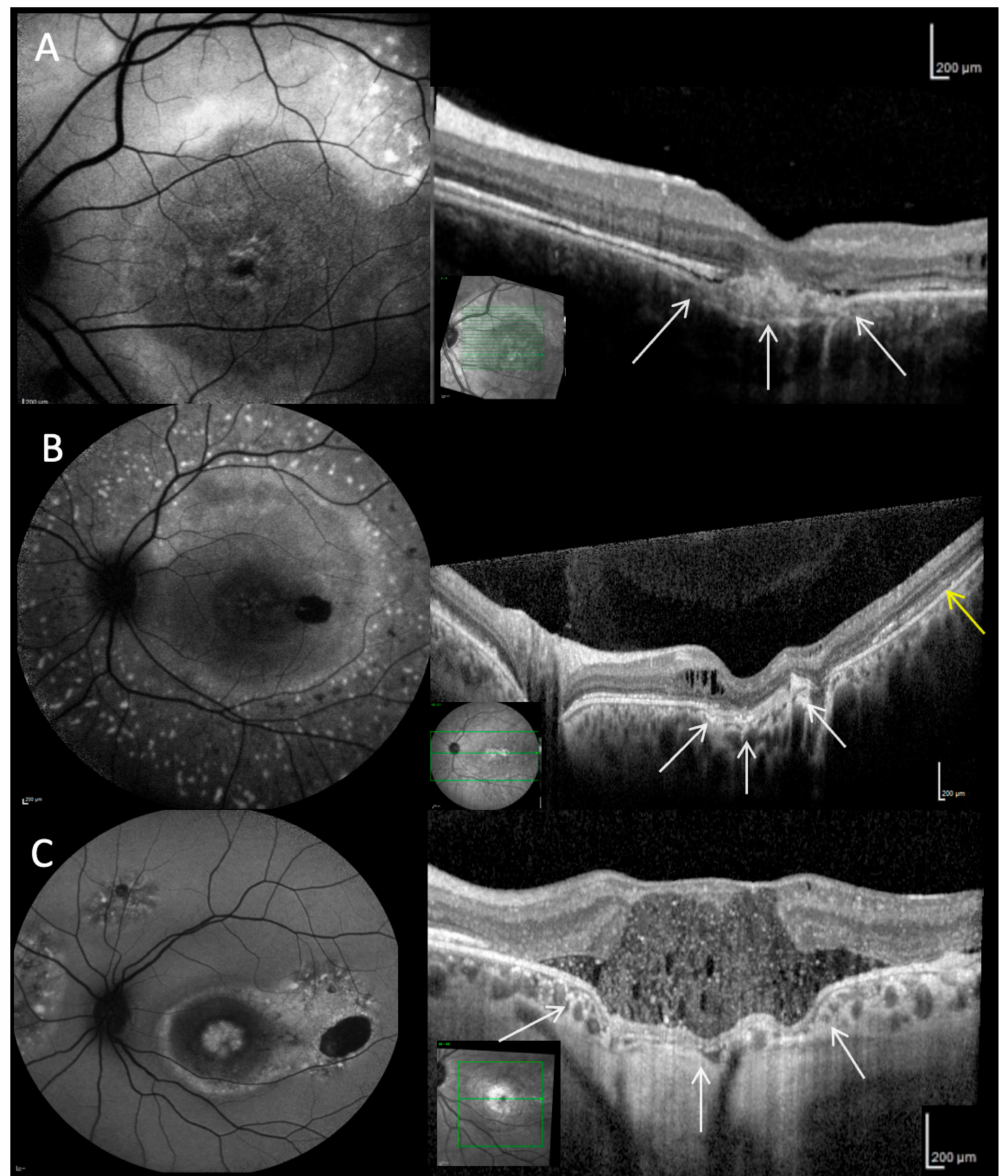
Figure 4. Focal and large choroidal excavation. ( A ) FAF 30 ◦ image shows confluent subretinal deposits with increased intensity arranged concentrically around the fovea (#2). OCT shows focal choroidal excavation (white arrows), a large lesion below the RPE / Bruch’s membrane complex subfoveally. Temporally, few intraretinal cystoid lesions are visible. ( B ) FAF 55 ◦ image shows multiple apparent spots with increased intensity surrounding the vessel arcades in a starry sky-like appearance (#8). The wide-field OCT shows foveal atrophy of the inner and outer retinal layers, intraretinal cystoid lesions in the papillomacular area, and focal choroidal excavation (white arrows). Temporally, a thickening of the outer retinal layers (yellow arrow) is visible. ( C ) FAF 55 ◦ image shows a lesion with reduced intensity in the macula and multiple regions with increased intensity in the mid-peripheral retina (#18). The OCT image shows a very large choroidal excavation (white arrows), associated marked thinning of the inner retinal layers and in between a large cystoid space with highly reflective